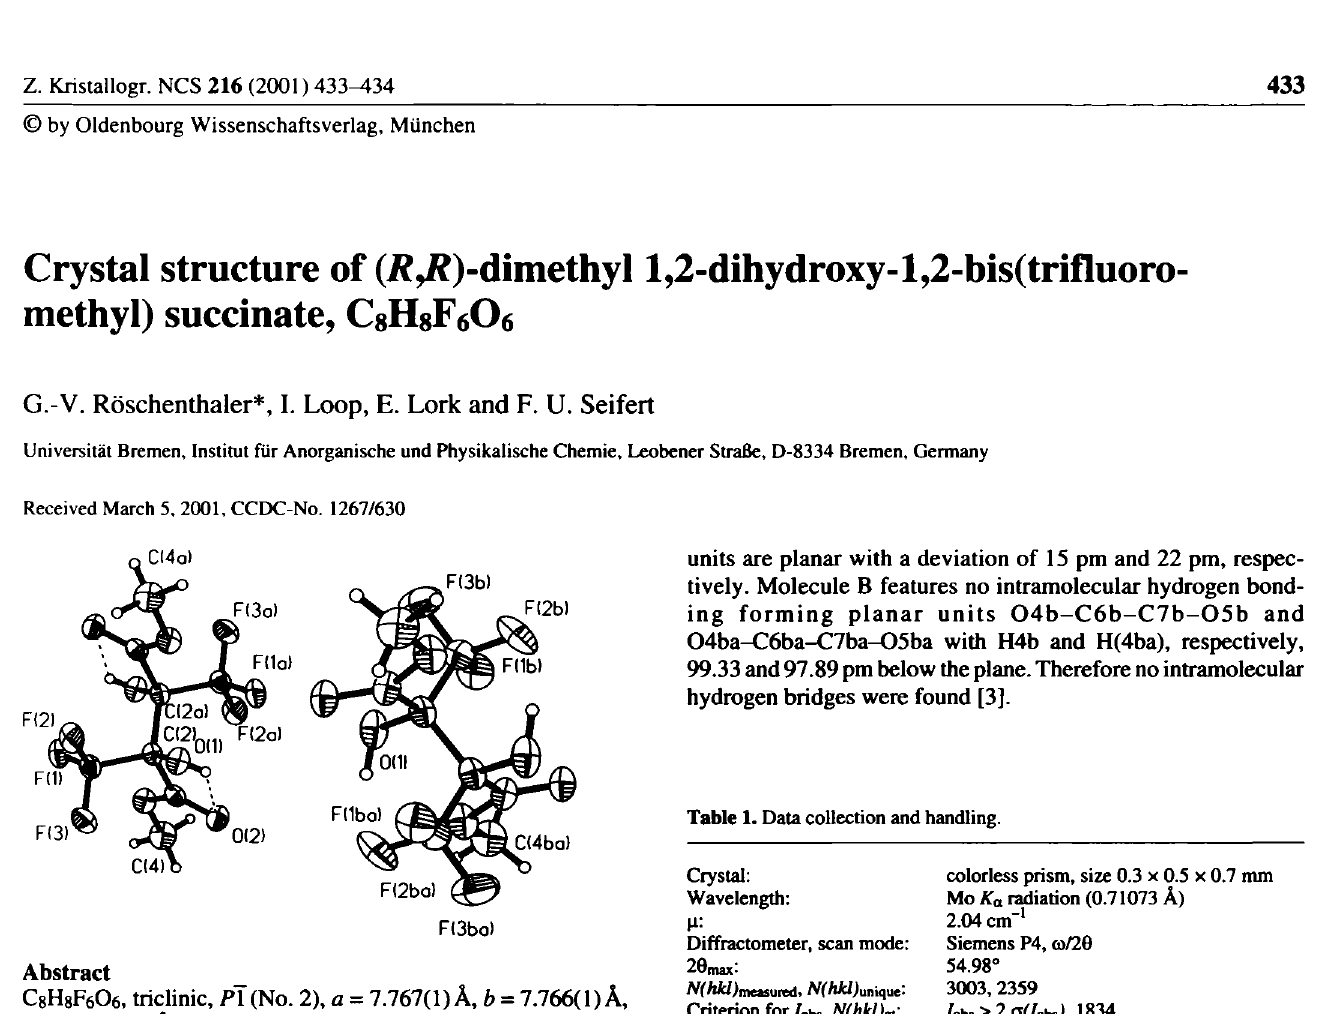
Table 2. Atomic coordinates and displacement parameters (in A 2 ).